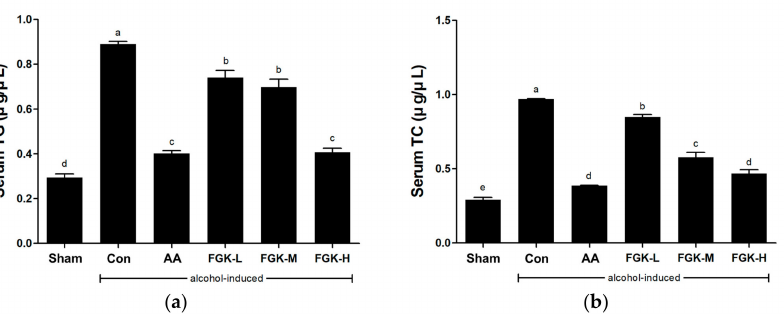
Figure 5. Effects of fermented gold kiwi (FGK) on serum lipid profile levels in alcohol-induced mice. ( a ) Triglyceride (TG); ( b ) total cholesterol (TC). Sham, mice treated with only saline; Con, mice treated with alcohol and saline; AA, mice treated with alcohol and ascorbic acid (25 mg/kg); FGK-L, -M, -H, mice treated with alcohol and FGK at 50, 126, and 250 mg/kg, respectively. Results expression as means ± SEM ( n = 8). a–e Different letters indicate significant differences ( p < 0.05) among the groups, as determined by Tukey’s analysis.